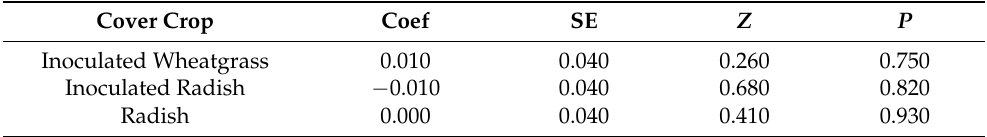
Table 3. Summary of the fitted Cox proportional hazard model for inoculated seed preferences. Coef indicates variable coefficients, SE indicates the standard error, Z is the test statistic used, and P indicates the significant values. Model output for month and temperature can be found in the Supplemental Materials (Table